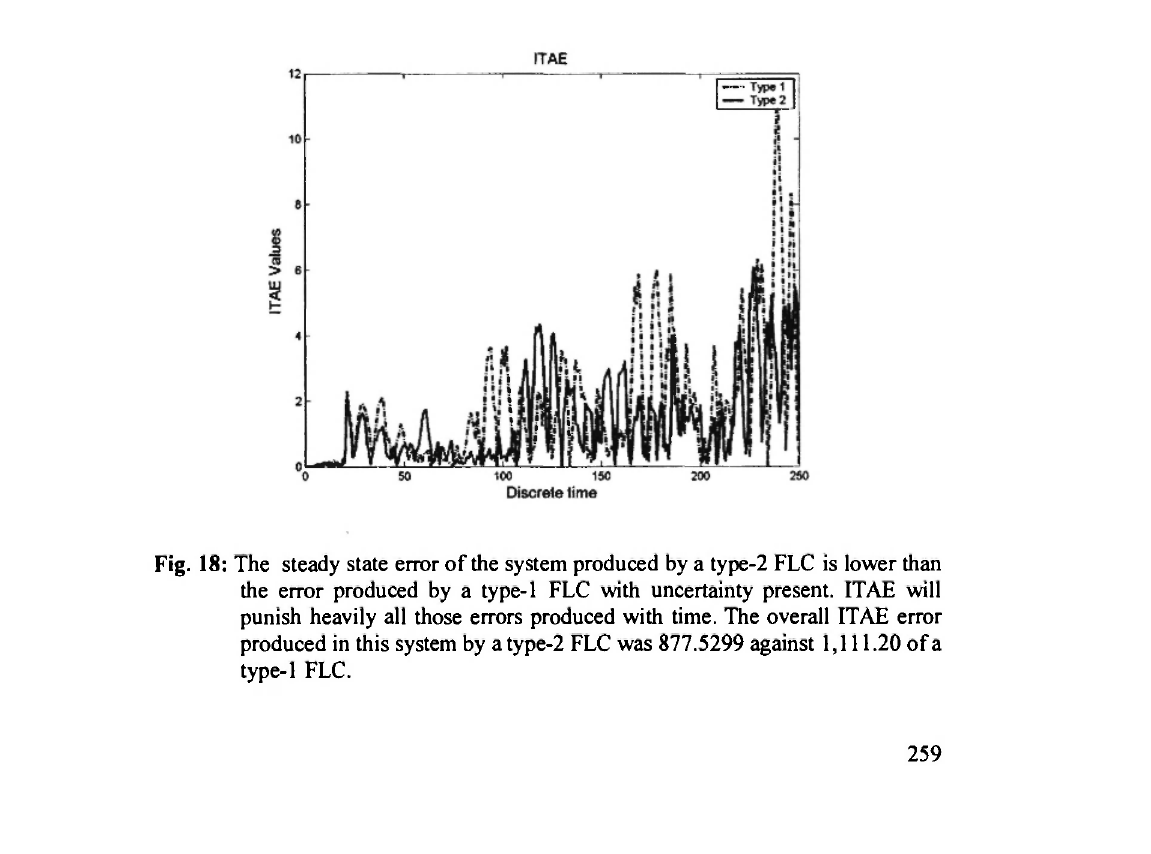
Fig. 17: I η accordance with Fig. 15, IAE confirms that we obtained the best system response using a type-2 FLC with uncertainty presence. The error of the settling time and steady state is lower using a type-2 FLC. The overall error is 45.4106 against 57.95 in favor of type-2 FLC.